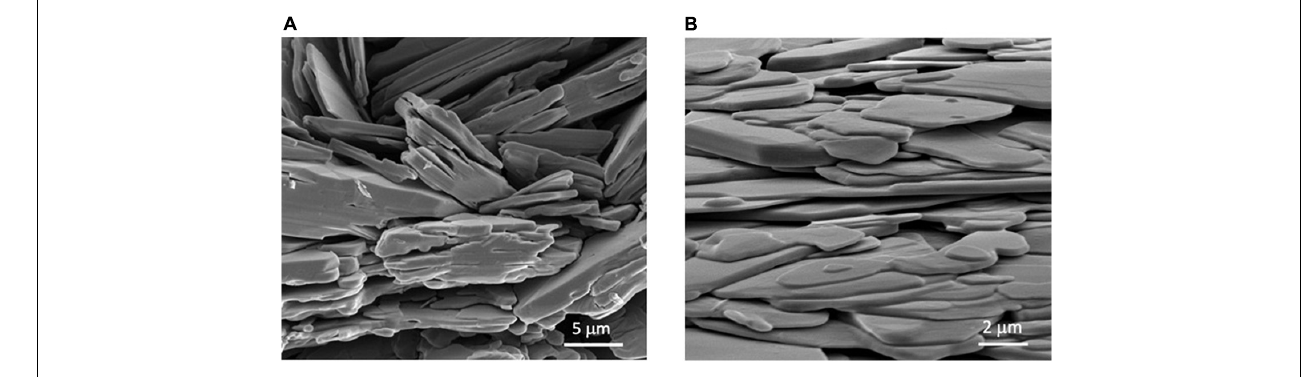
FIGURE 5 | SEM images (A) VOP1 and (B) VOP2.